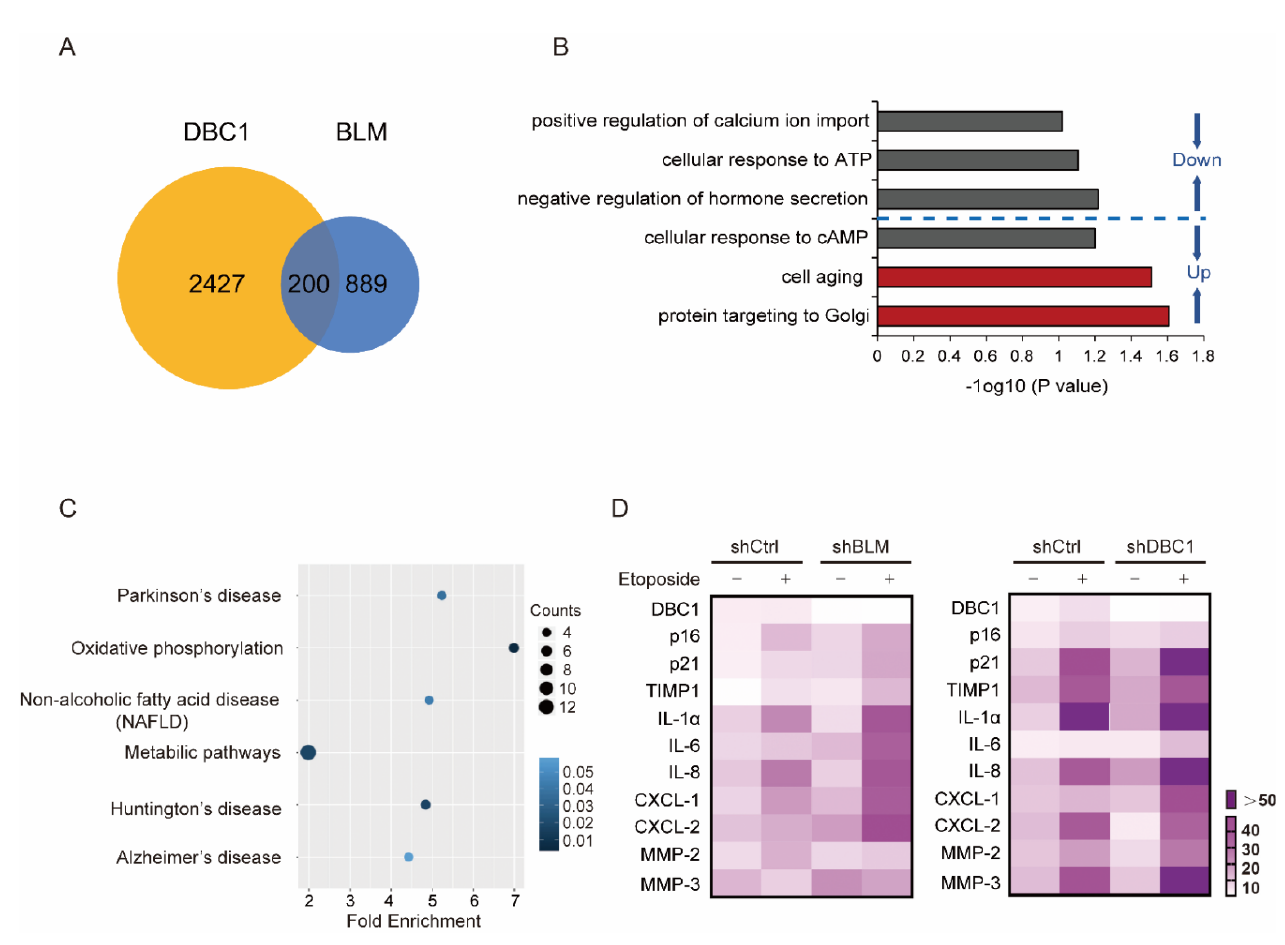
Figure 3. DBC1 and BLM co-regulate the expression of senescence-associated genes. ( A ) The common differentially expressed genes in DBC1 knockdown and BLM knockdown cells presented in the form of a Venn diagram. ( B ) Gene ontological analysis of the common differentially expressed genes in DBC1 knockdown and BLM knockdown cells, performed with –log 10 (p value) plotted as a function of classification meeting a p value of < 0.05. ( C ) KEGG enrichment analysis of the common differentially expressed genes in DBC1 knockdown and BLM knockdown cells compared to control cells. p value of < 0.05. ( D ) Gene expression changes in senescence-associated genes in DBC1 knock- down or BLM knockdown cells, with or without etoposide-induced DNA damage (50 μM, 24 h).